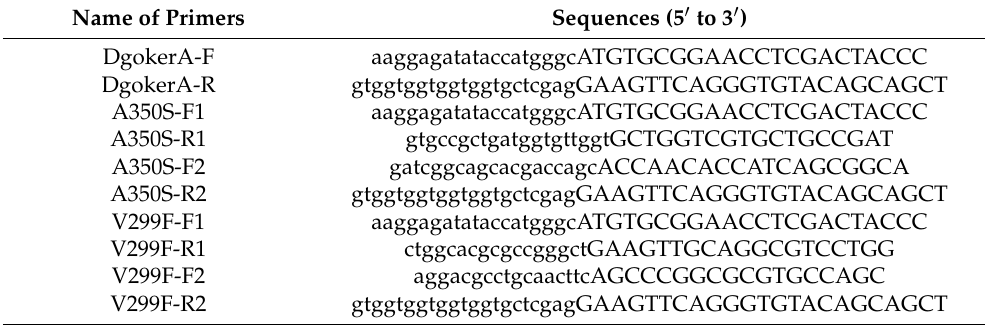
Table 1. Primers used in this